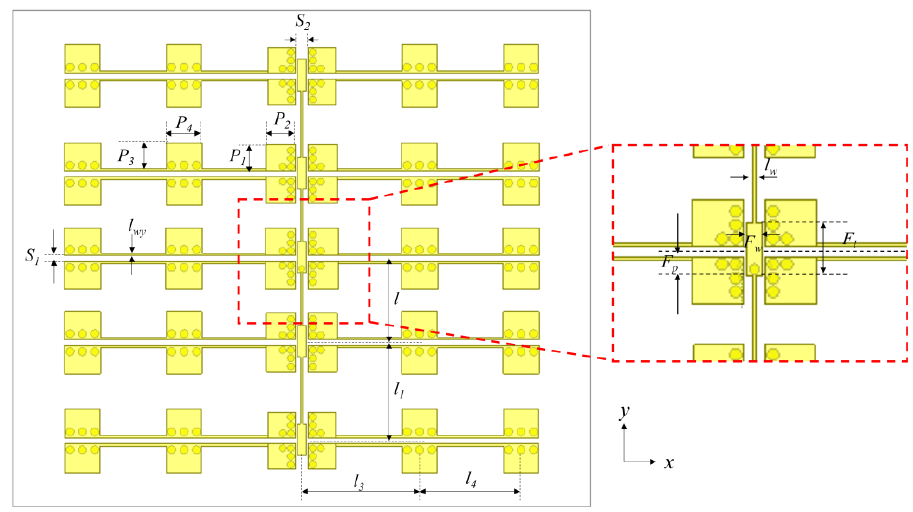
Figure 1. The 5 × 5 interconnected ME dipole antenna array